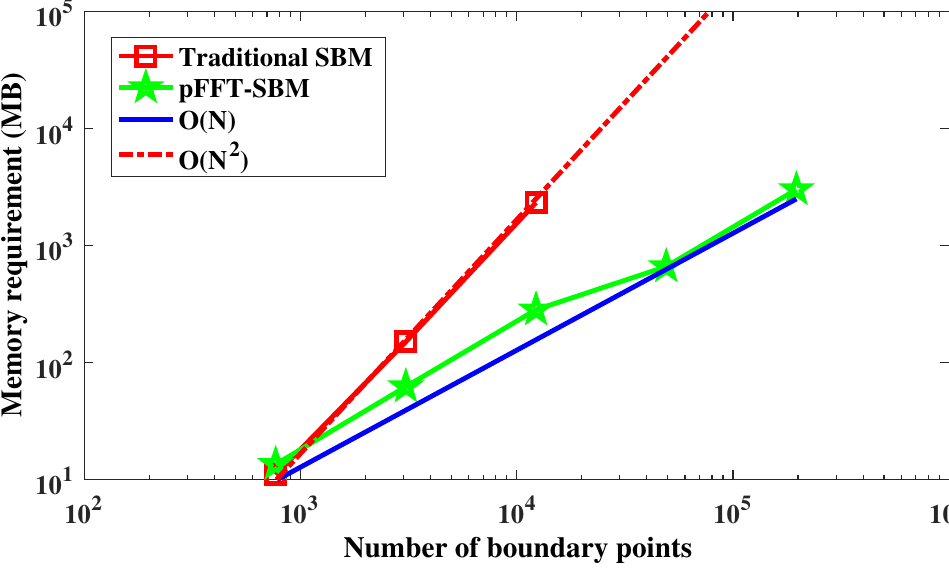
Figure 2. Memory requirements versus the problem size for example 1.